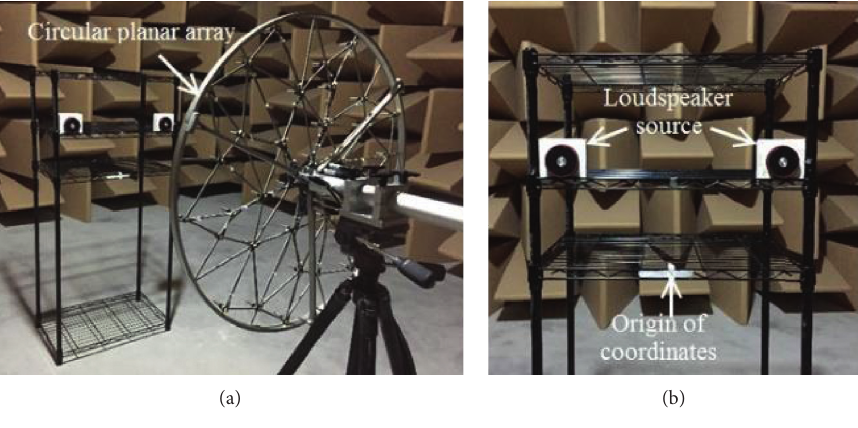
Figure 8: Experimental